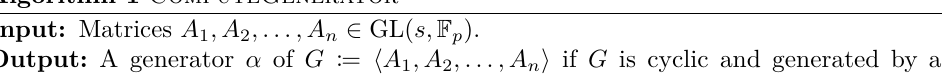
Algorithm 1 ComputeGenerator